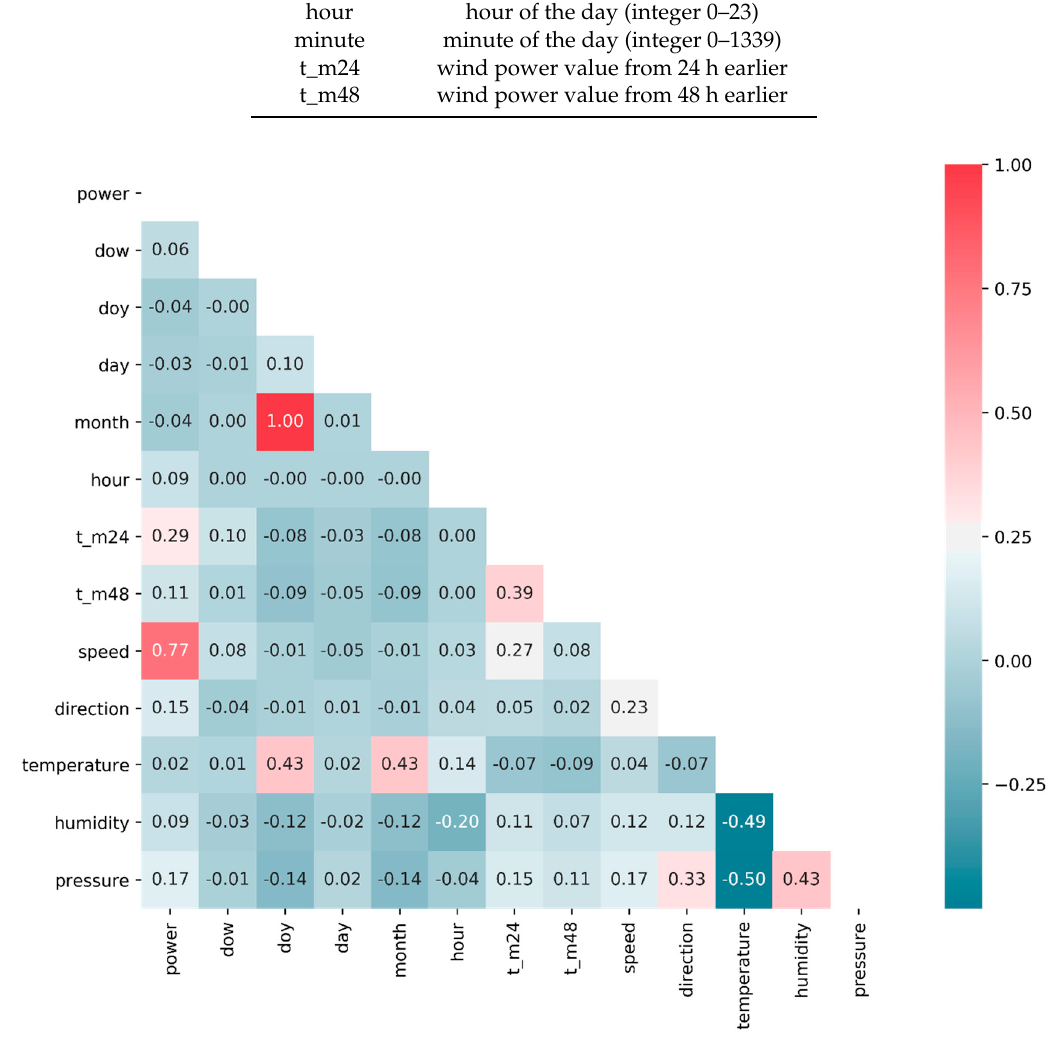
Figure 1. Heatmap of Pearson correlation coefficient matrix.